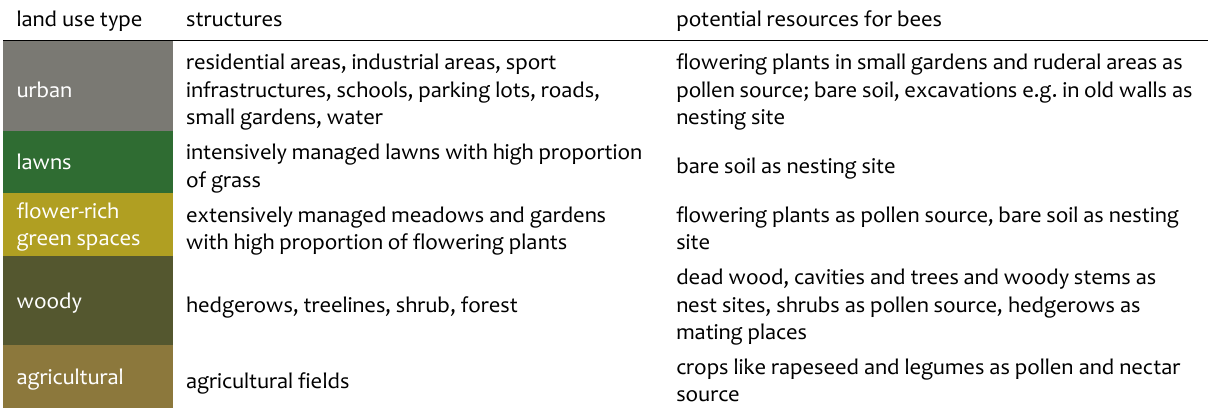
Table 3. Land use types and potential resources for